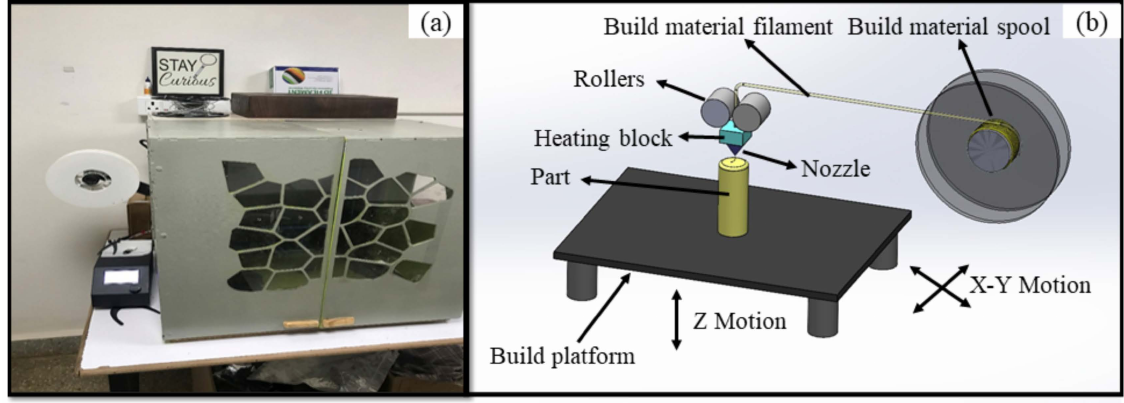
Figure 1. Experimental set-up: ( a ) CR 10 3D printer, and ( b ) schematic view of FDM printer.